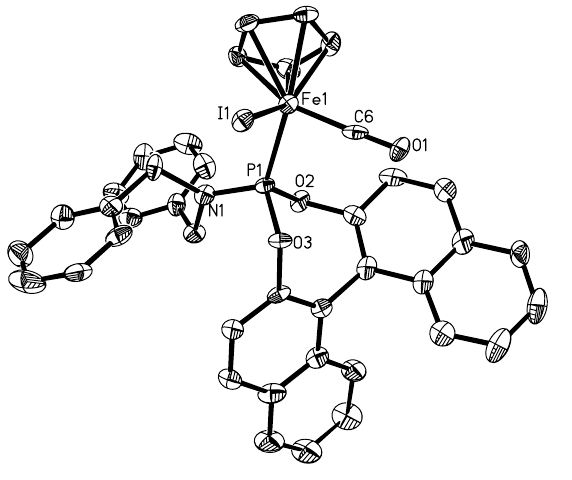
Figure 3. Molecular structure of one of the diastereomers of 5b (depicted with 65% probability ellipsoids, H atoms, and solvents are omitted for clarity). Key bond lengths and bond angles are listed in Table 2.